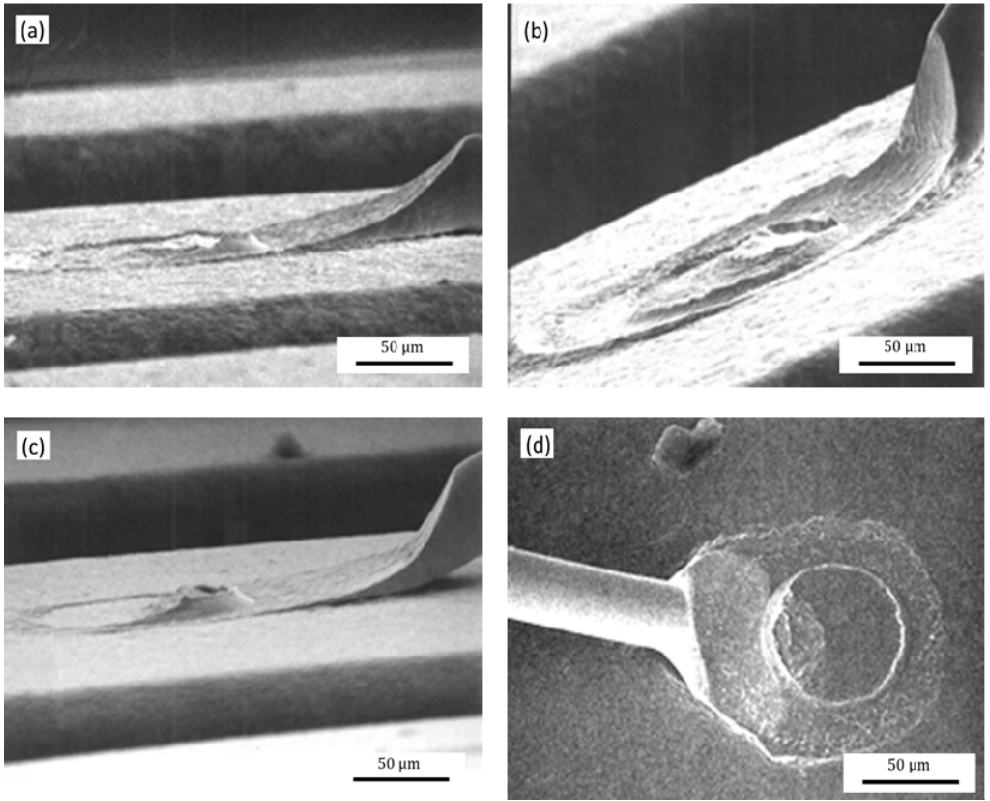
Figure 16. The morphology of the second bonded point when the OCR is: ( a ) 25.4 μ m; ( b ) 20 μ m; ( c ) 30 μ m; ( d ) the second bonded point with small OCR.